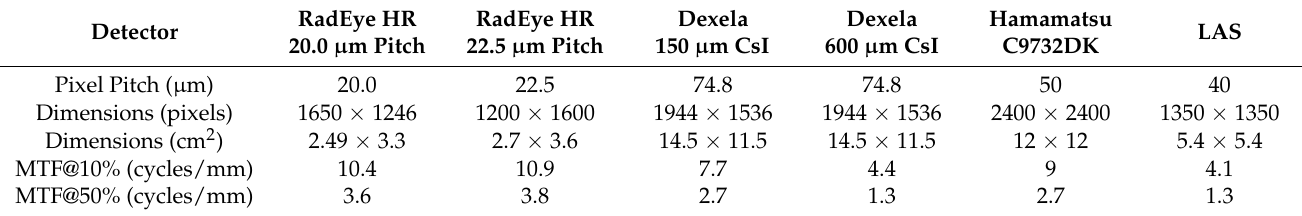
Table 1. MTF values at 10% and 50% for various CMOS X-ray detectors [32].